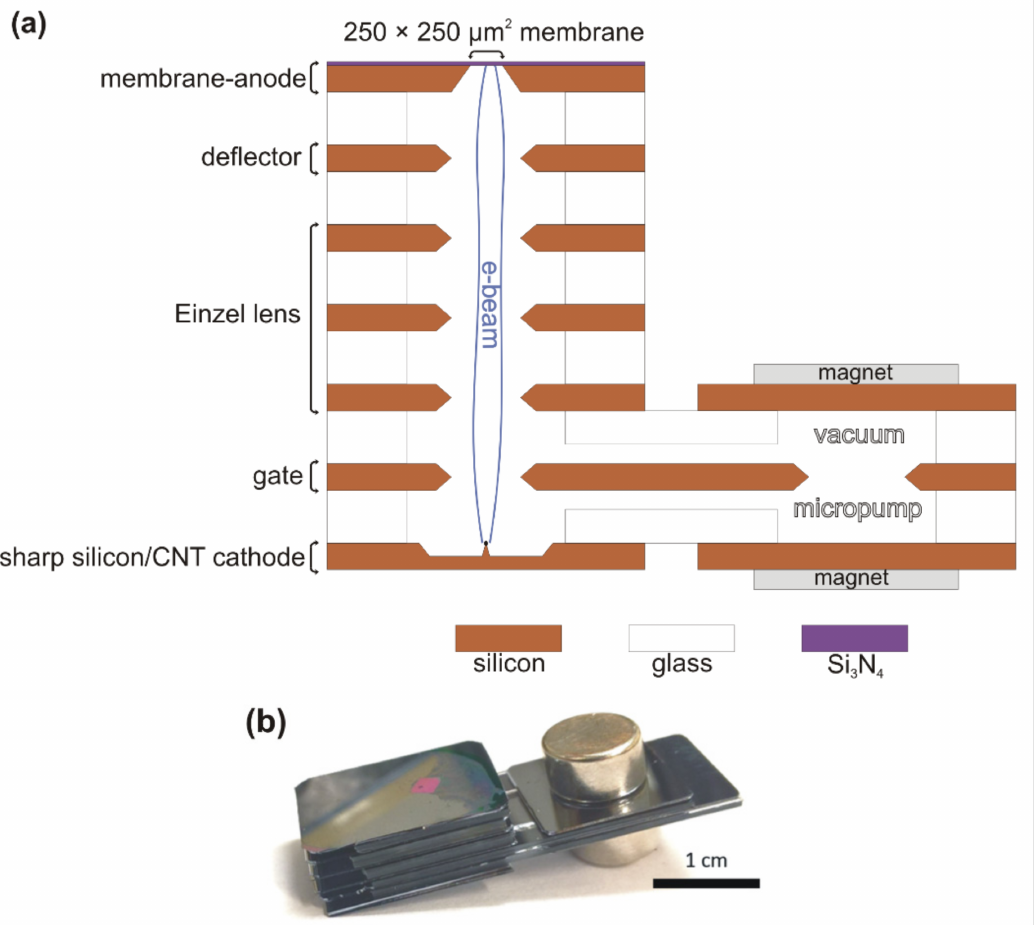
Figure 1. Concept of the complete MEMS electron microscope: ( a ) scheme; ( b ) photo of the assembled structure without